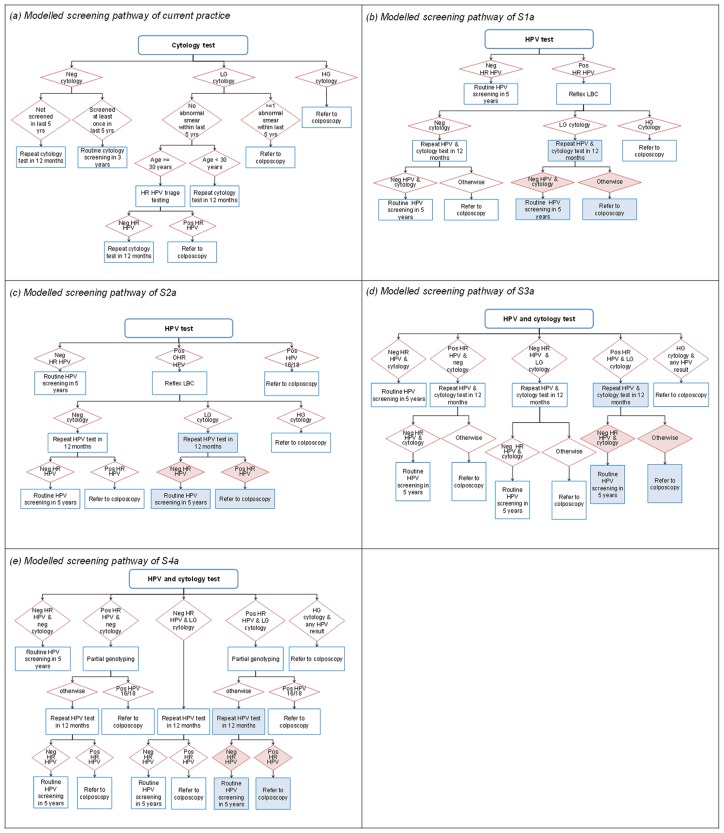
Modelled screening pathways of (a) CP, (b) S1a, (c) S2a, (d) S3a and (e) S4a. Coloured boxes indicate variations in other sub-strategies assessed.HG- High-grade (including ASC-H and HSIL); HR HPV– high risk HPV; LG –low-grade (including ASC-US and LSIL); Neg—Negative; OHR HPV- non-16/18 high -risk HPV